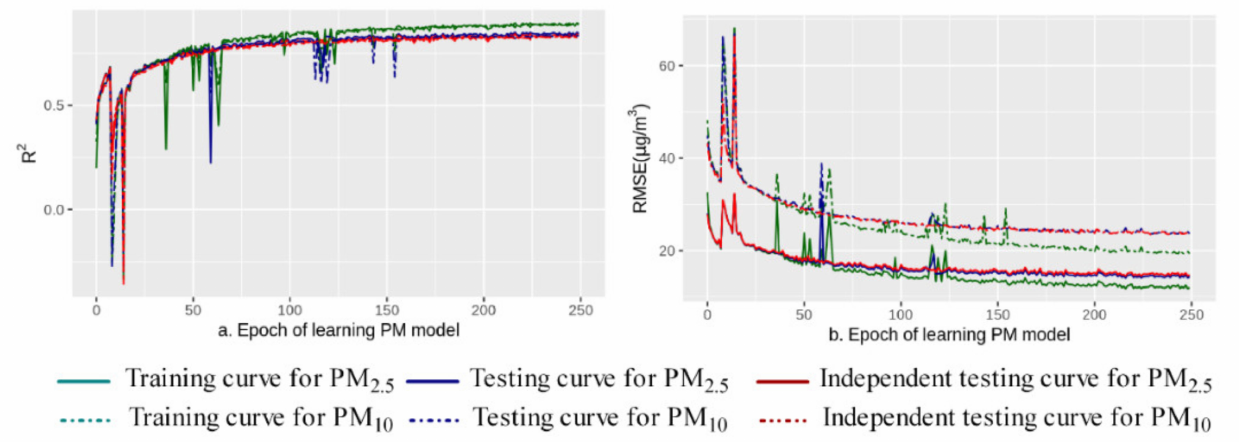
Figure 6. Curves of training, testing and site-based independent testing for R 2 ( a ) and RMSE ( b ). The optimal model was trained using the proposed method (Table 2): training R 2 of 0.91, testing R 2 of 0.84–0.85 and site-based independent testing R 2 of 0.82–0.83; training RMSE of 9.82 µ g/m 3 for PM 2.5 and 17.02 µ g/m 3 for PM 10 , testing RMSE of 13.87 µ g/m 3 for PM 2.5 and 23.54 µ g/m 3 for PM 10 and site-based independent testing RMSE of 14.51 µ g/m 3 for PM 2.5 and 24.34 µ g/m 3 for PM 10 . The scatter plots between observed values and predicted values in the site-based independent testing (Figure 7) showed that most